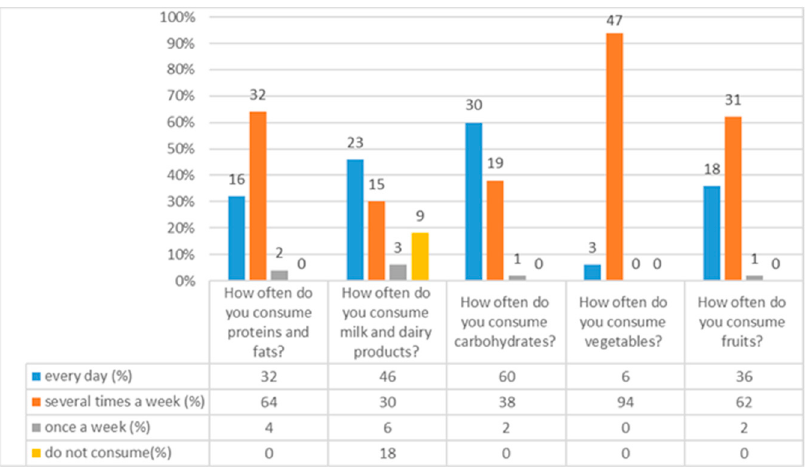
Figure 8. Distribution of users by frequency of intake of macronutrients, milk, and milk products, vegetables, and fruits absolutely and relatively.